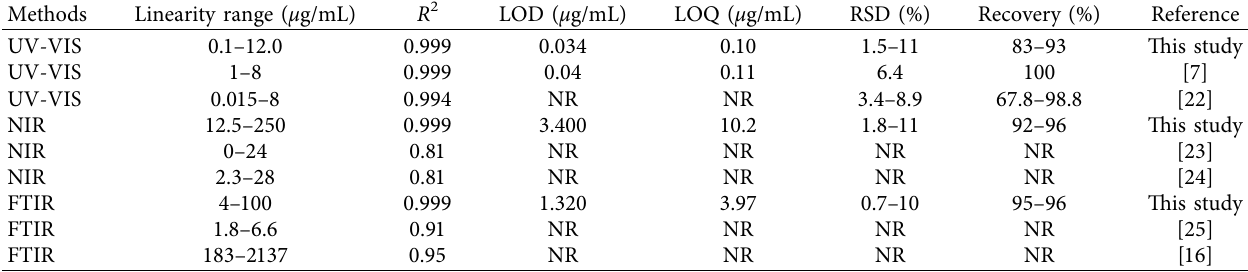
Table 4: Analytical parameters of the proposed methods such as R 2 , LODs, LOQs, RSDs, and recoveries compared with the previously published methods.